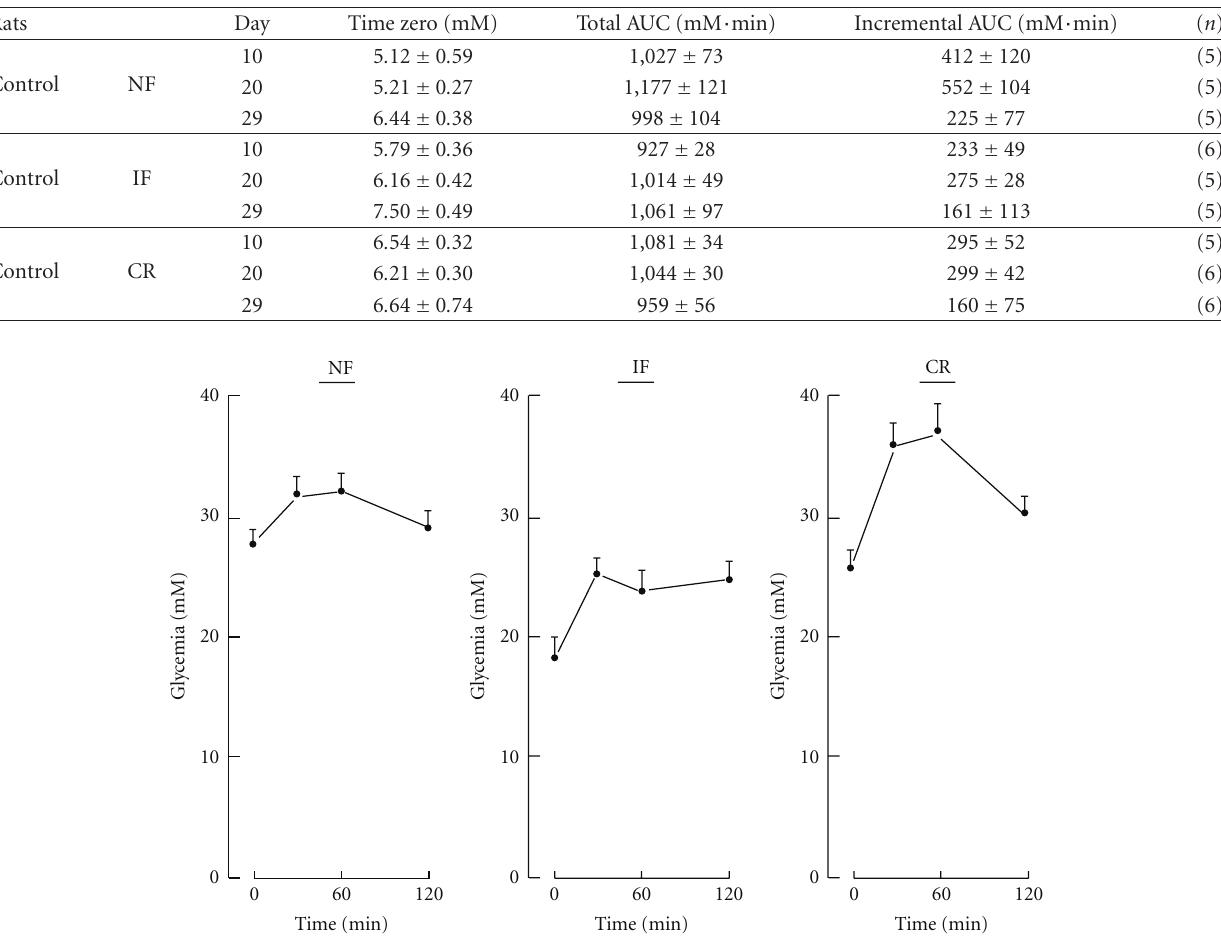
Table 2: IPGTT glycemic data in control rats.